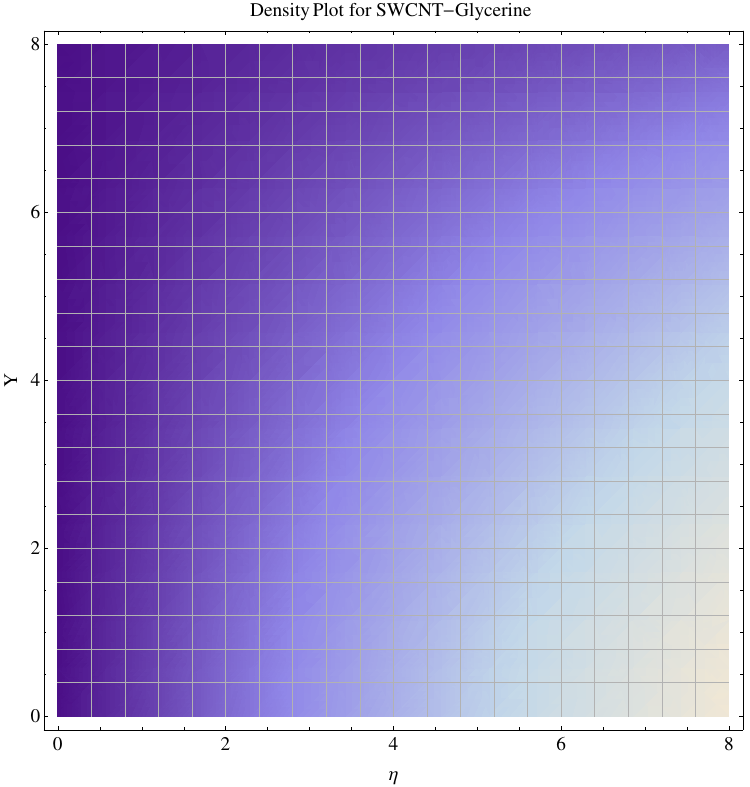
Figure 23. Density graph of single-walled nanotubes—Glycerine dilute.